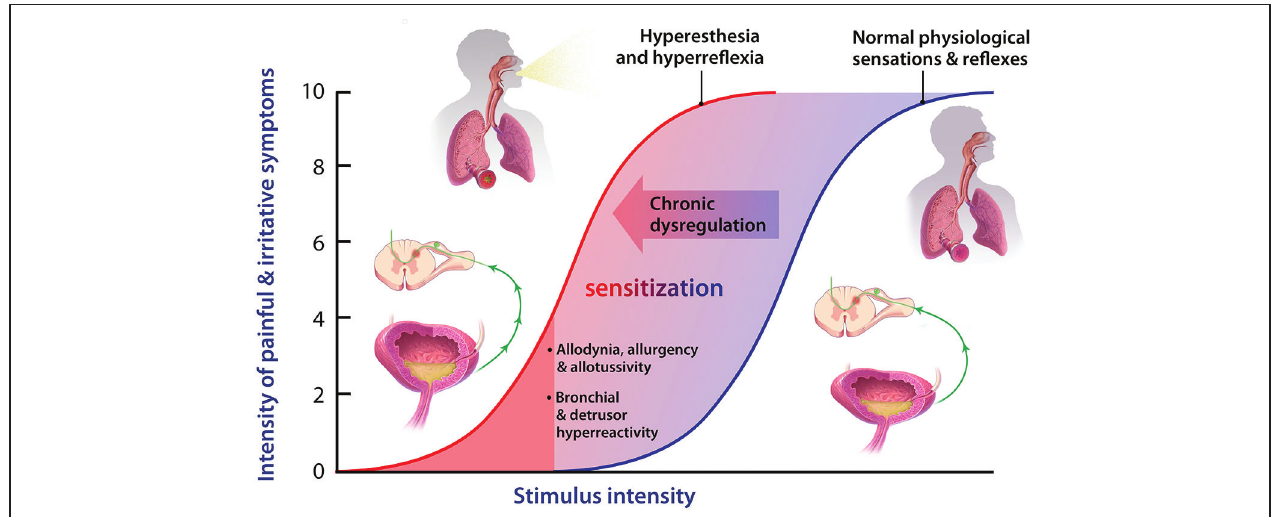
FIGURE 2 | Normal physiological sensory perception and reflexes are important defensive mechanisms, under conditions of acute stress or physical threat, when a high stimulus intensity (blue sigmoid) represents potential harm . During chronic dysregulation, afferent functions experience sensitization, wherein normally low threshold or sub-threshold